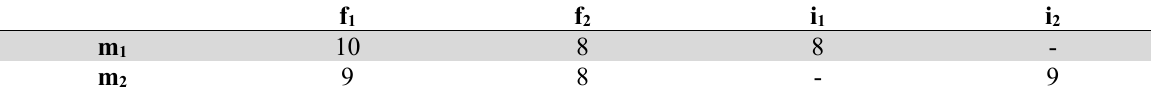
Supply and demand of each raw material (in